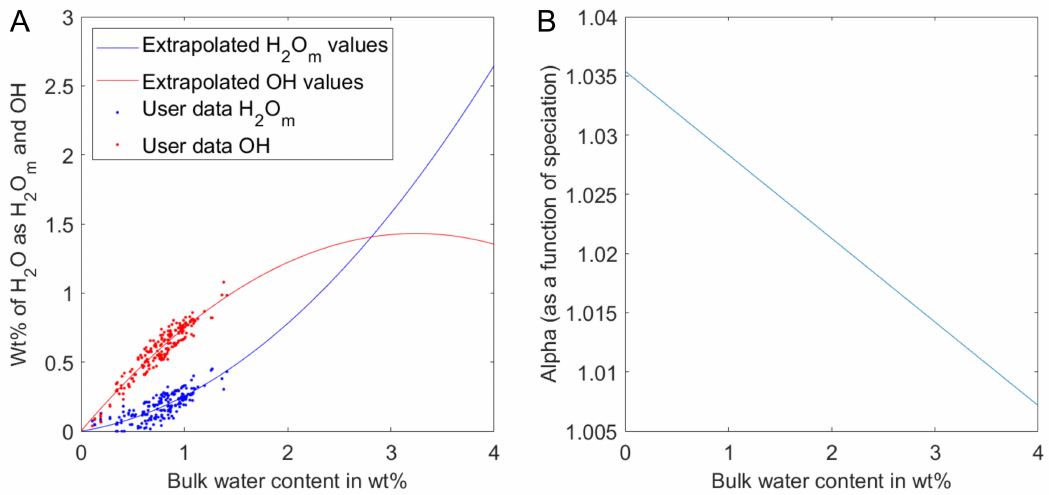
Figure 4: [A] Plots displaying natural hydrous speciation data (red and blue dots) in obsidians (wt.% OH and H O) from the Chaitén eruption, 2008 [Castro et al. 2012; Forte and Castro 2019] in relation to bulk H 2 Curves are 2nd degree polynomial fits to each species. [B] The graph shows the calculated VolcDeGas alpha factor trend, which is based on hydrous speciation extrapolations shown in